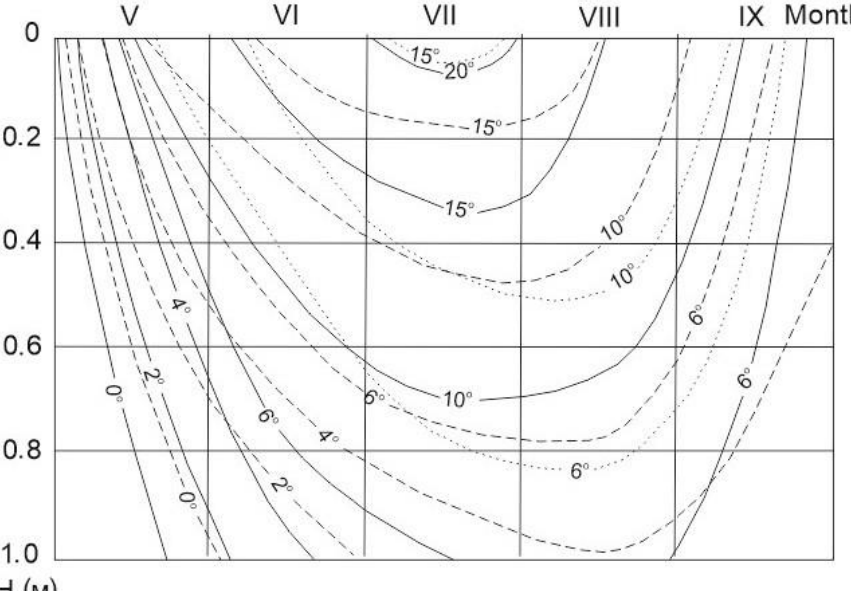
Figure 7. Thermal isopleths for sandy loamy (solid line) and loamy (dashed) soils of above-floodplain terraces and swampy soils (dashed line) of the Lena River floodplain [36].